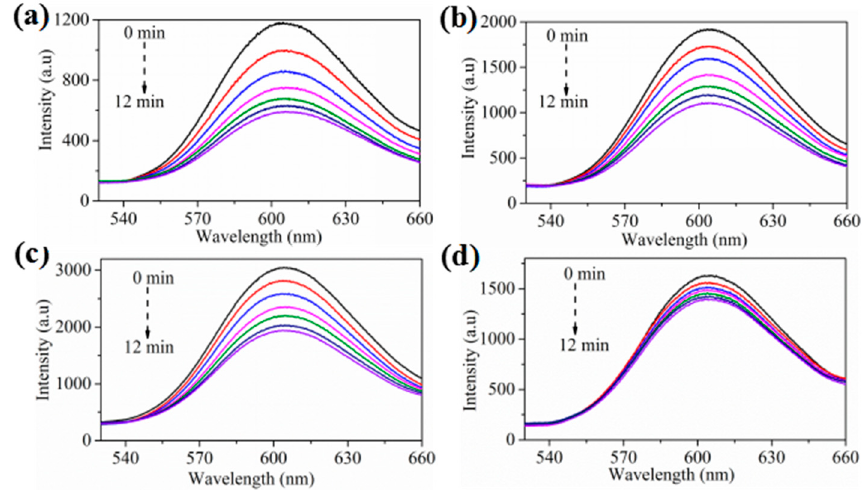
Figure 4. Time-dependent fluorescence emission spectra of the nanofibrous membranes ( a ) PU-1, ( b ) PU-2, ( c ) PU-3, and ( d ) PU-4 upon exposure to 4 ppb of trinitrotoluene (TNT) vapor.